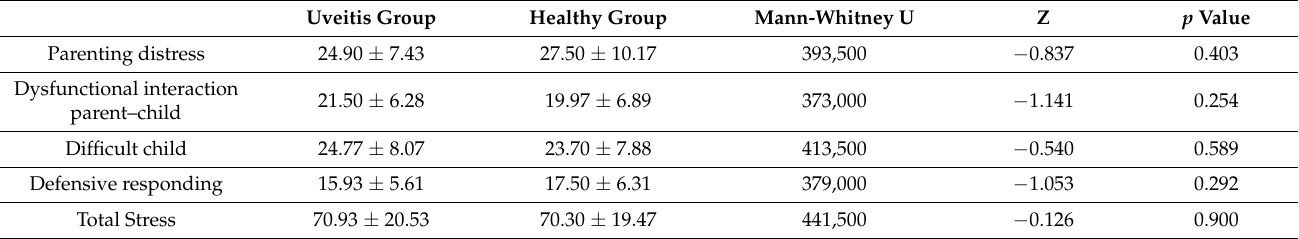
Table 3. Differences scores between groups found in PSI.